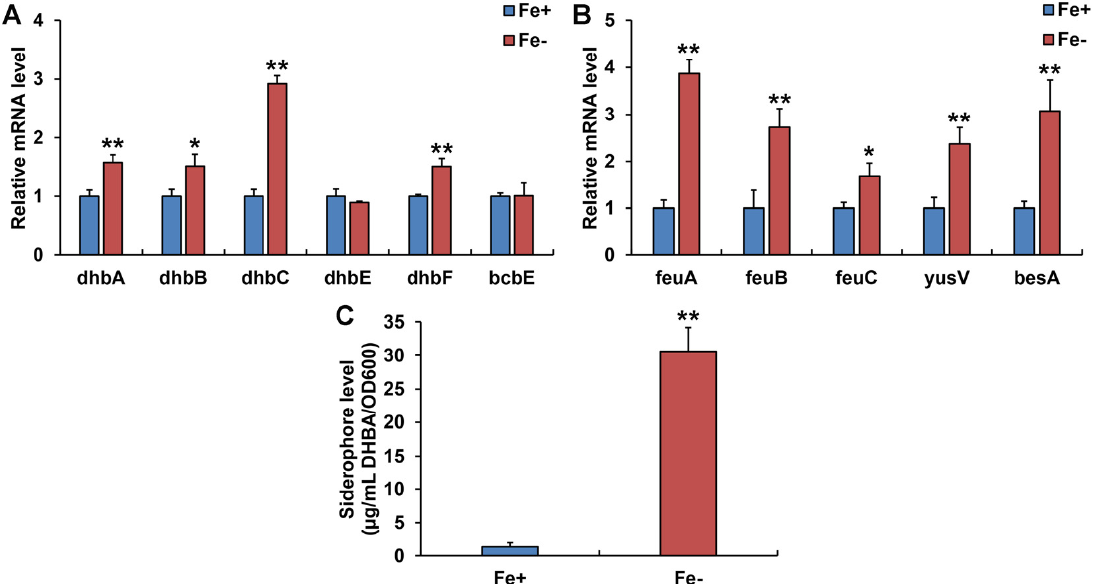
Figure 3. Siderophore-related gene expression and siderophore production in Bacillus sp. WR13 under Fe-sufficient (Fe+) and Fe-deficient (Fe − ) conditions. ( A ) Gene expression related to siderophore synthesis and transportation; ( B ) gene expression related to Fe-BB uptake and hydrolysis. ( C ) Quantitative analysis of siderophore. Data are expressed as the means ± SD ( n = 3). * p < 0.05 and ** p < 0.01 indicate significant and extremely significant differences.